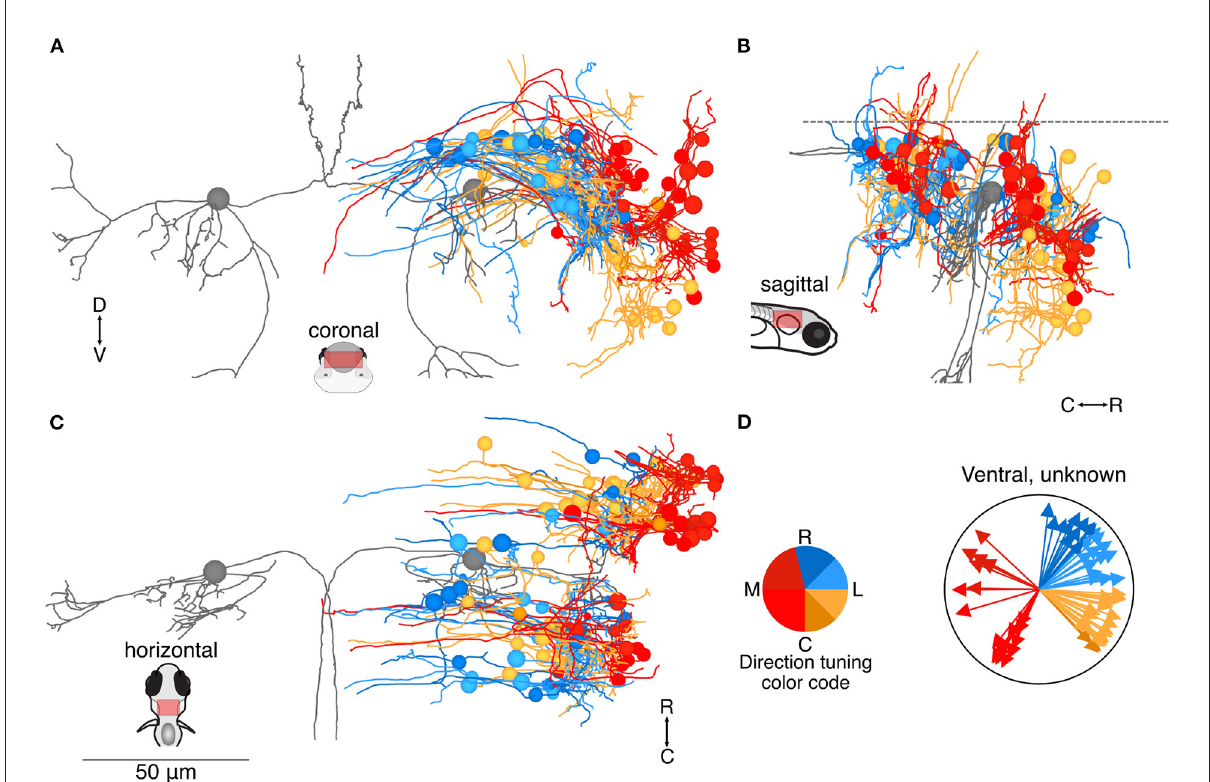
FIGURE4 Location and directional tuning of ventrally located neurons receiving utricular input. (A) Coronal projection of reconstructions of 83 ventral neurons that receive direct utricular afferent input, colorized by their inferred directional tuning [see color code, (D) ]. In addition, the left and right Mauthner cells are shown in gray to facilitate comparisons with other results. Neurons responsive to contralateral tilt (reds) are preferentially located on the lateral edge of the vestibular brainstem (see Figure 7). (B) Sagittal view of the same neuron reconstructions as in (A) . Ventrally located neurons are distributed both rostrally and caudally to the Mauthner cell body. (C) Horizontal view of the same neurons as in (A) . Scale bar applies to (A–C) . (D) Summary of the inferred directional tuning of ventral neurons with utricular input. Vector direction indicates the computed directional tuning of each neuron. Arrow lengths have been adjusted to facilitate